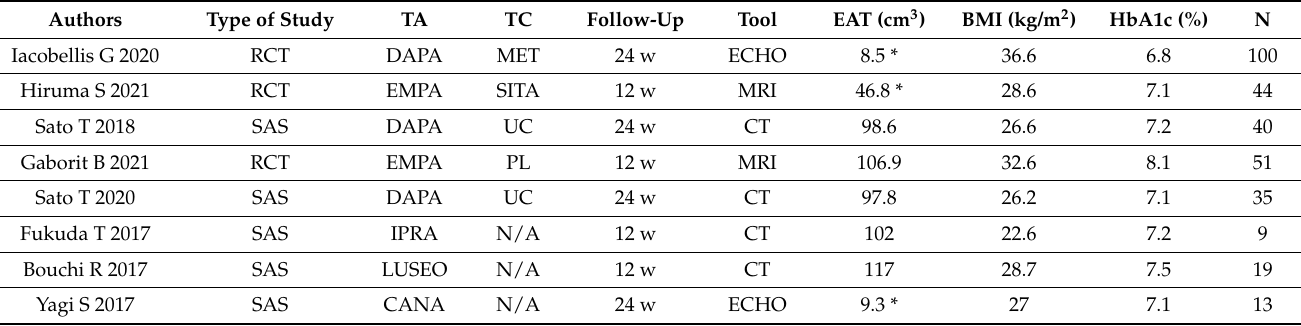
Figure 1. Flow diagram of the study screening process. Table 1. Characteristics of the included studies.